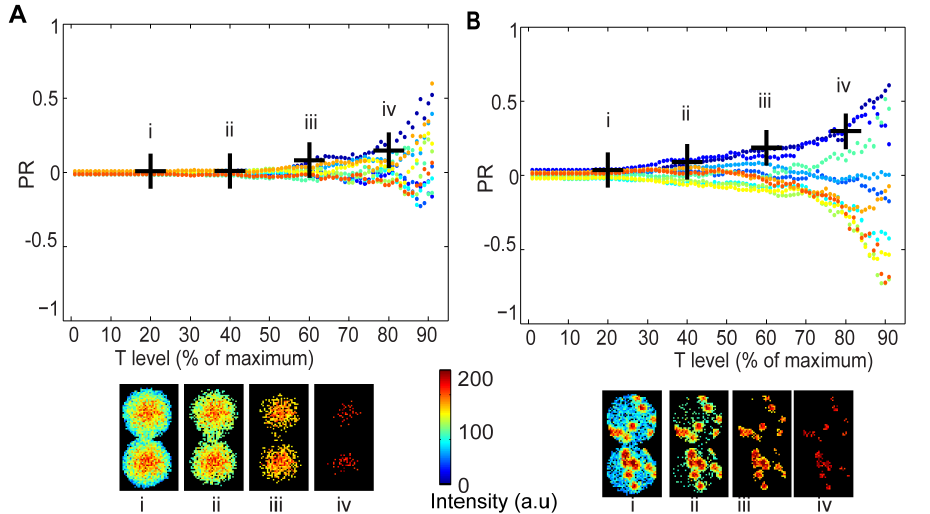
Figure 3. Ratio coefficients from synthetic data are dependent on the threshold value. 10 images of cells simulated to have symmetric fluorescence partitioning with non-clustered ( A ) and clustered localization ( B ) were simulated to quantify the effect of background subtraction on ratio coefficients. The horizontal axis represents the Threshold value. The vertical axis represents the PR. The possible range varies between -1 to 1, where 0 is maximum symmetry and high absolute ratios indicate maximum asymmetry. Different colors represent different simulated divisions. Black crosses represent the ratio and T value of illustrative images below. Input for simulation: h =0, R=22 pixels, number of clusters in both D1 and D2 was 20.